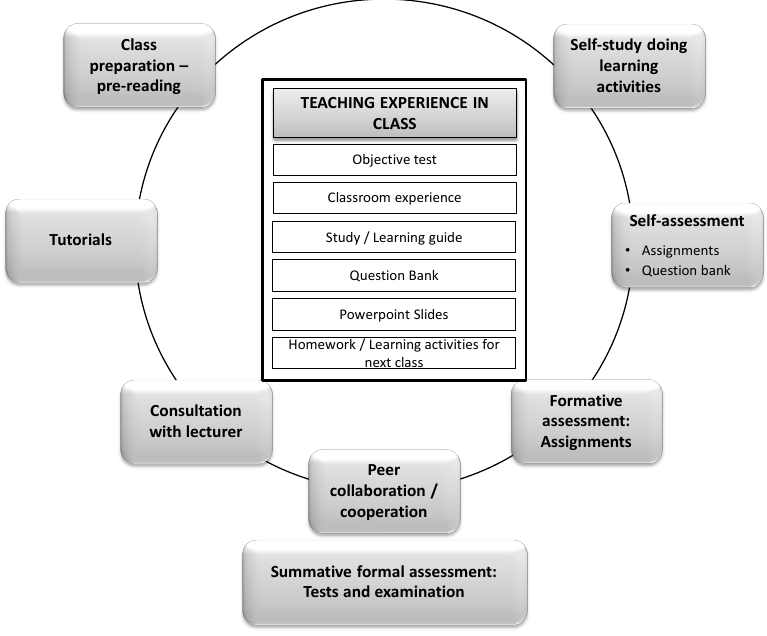
FIGURE 1: Diagrammatic presentation of the new teaching and learning strategy Source: Authors’